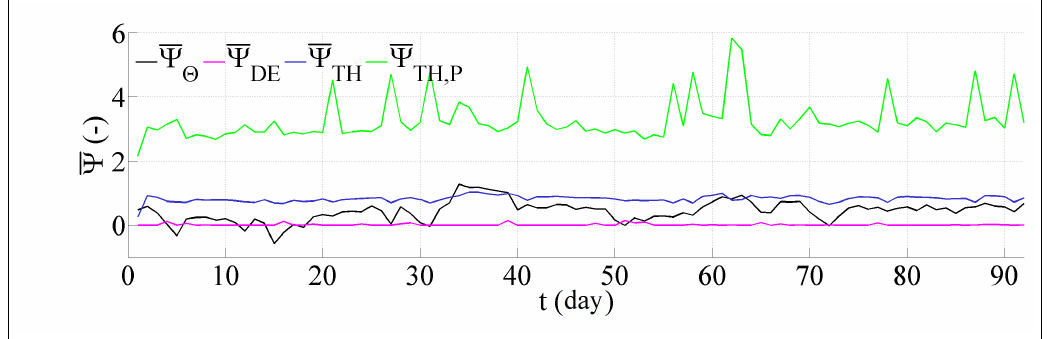
Figure 7. The values of the individual parts of the criteria function.